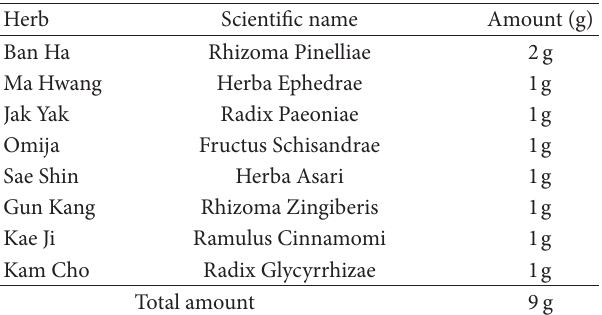
Figure 1: Effects of SCRT on pacemaker potentials in cultured ICCs from murine small intestine. (a)–(d) show the pacemaker potentials of ICCs exposed to SCRT (0–50 mg/mL) in current clamping mode ( 𝐼 = 0 ). Responses to SCRT are summarized in (e). Bars represent mean values ± SEs. ∗∗ 𝑃 < 0.01 . Significantly different from untreated controls. CTRL: Control. Table 1: Amount and Composition of